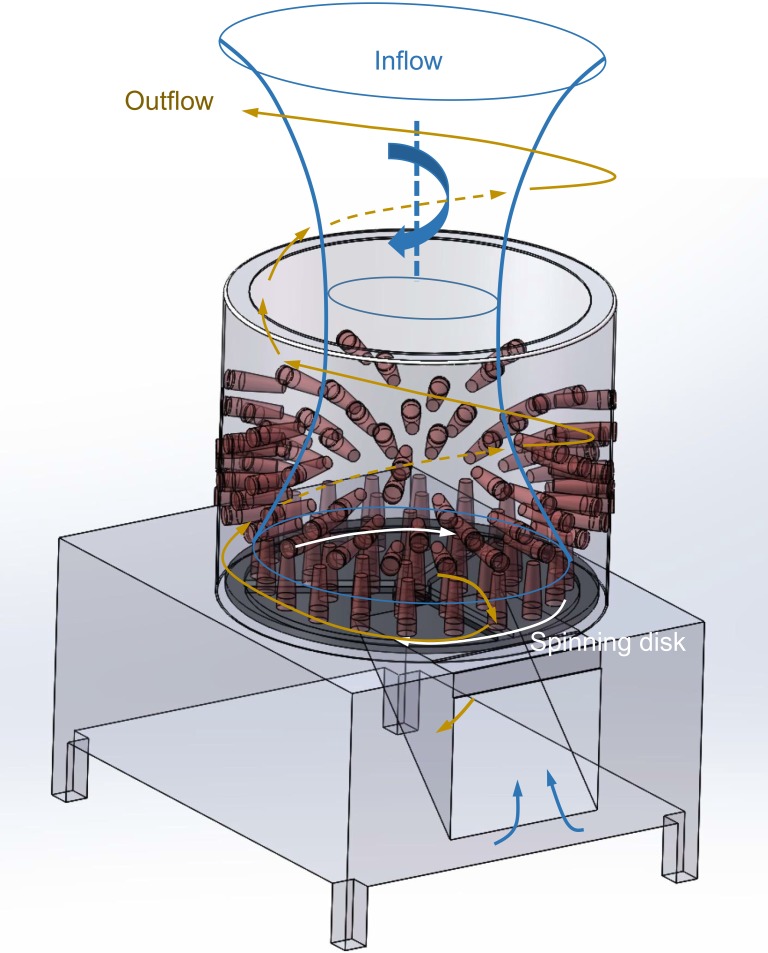
Illustration of the airflow pattern of operating mechanical defeatherers.